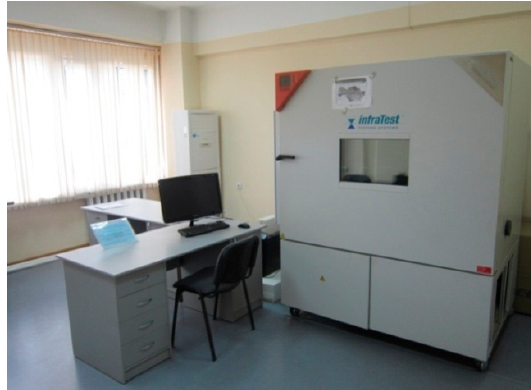
Figure 7. General view of the device for test at direct tension TRAVIS.